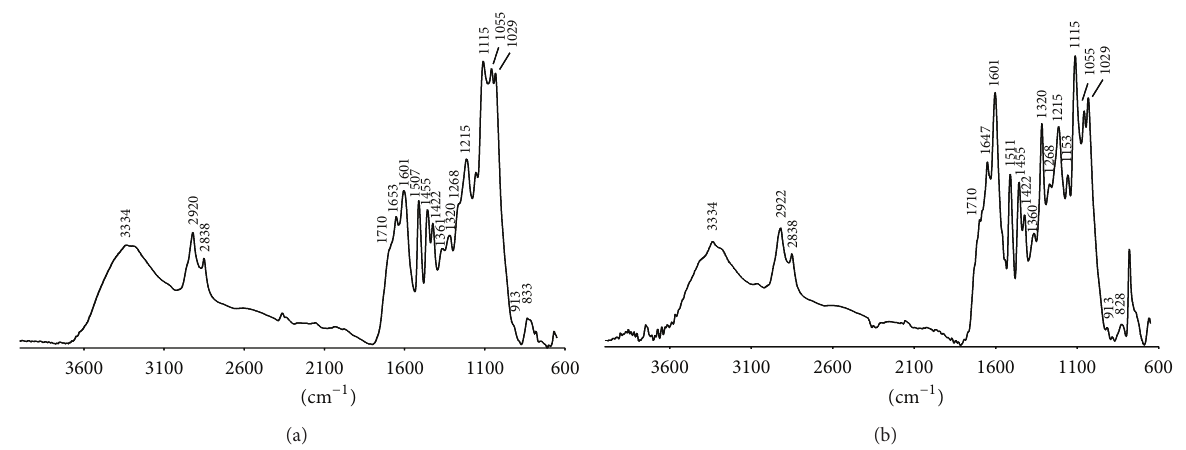
Figure 1: FTIR spectra, 4000–600 cm −1 region, of the lignin-rich residues from wheat straw (a) and olive tree pruning (b) WIS fractions.